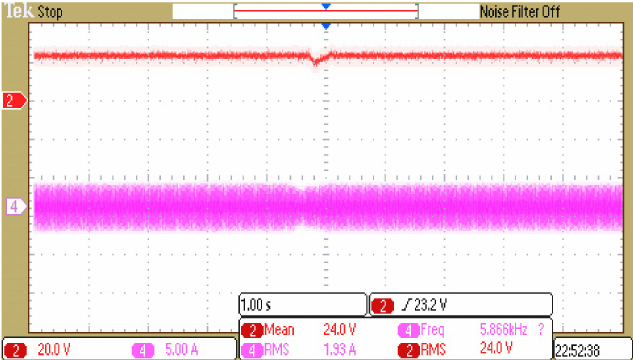
Figure 24. When the receiving coil of load #1 is offset by 2